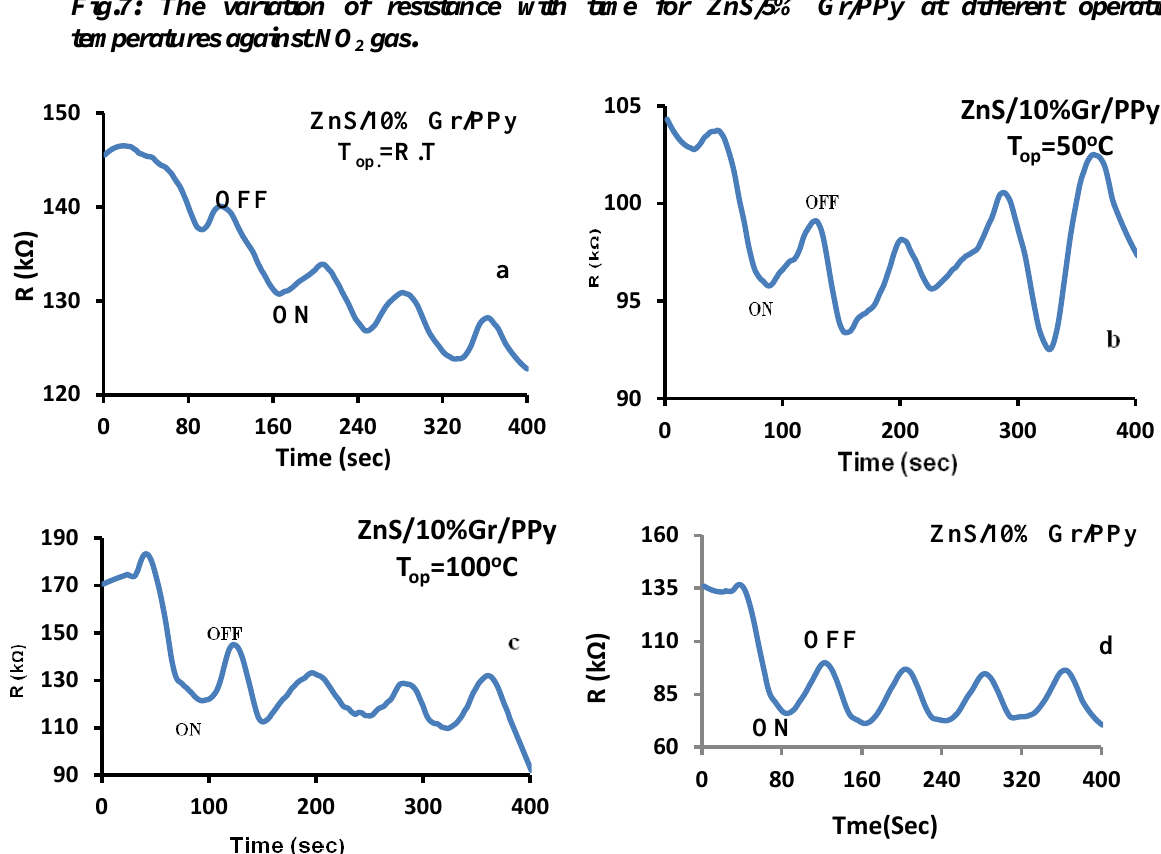
Fig.7: The variation of resistance with time for ZnS/5% Gr/PPy at different operating temperatures against NO gas. 2